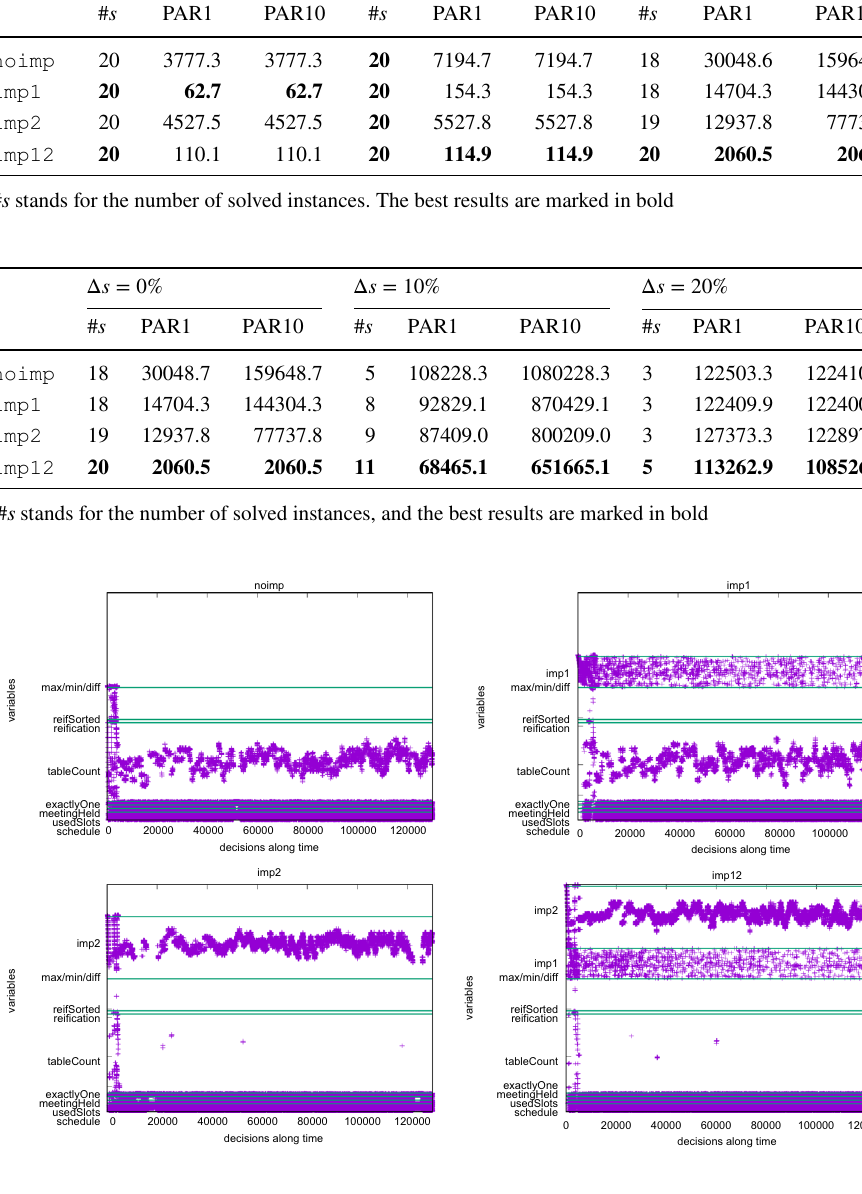
Table 1 Statistics of solving real-world B2B instances, varying their density d , for a fixed shape s (with Δ